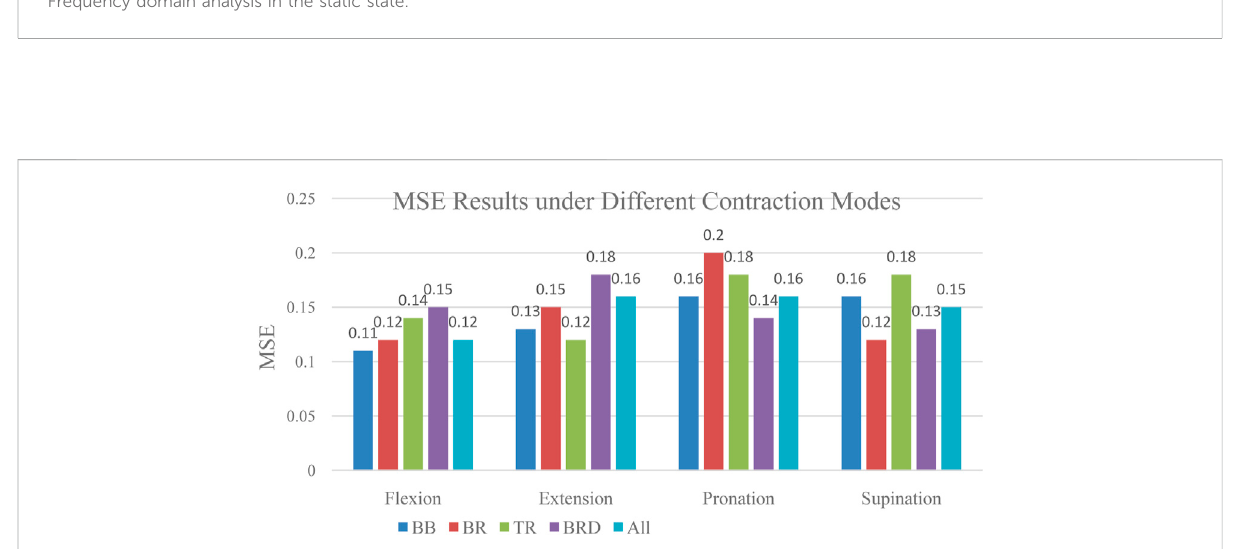
FIGURE 14 Prediction Results of Individual Muscle and Combined muscle Under Different